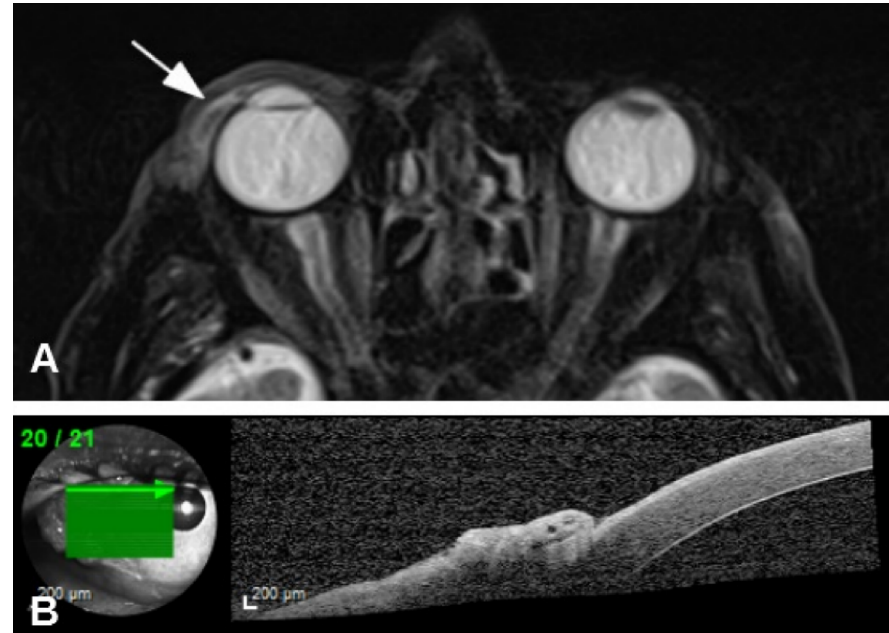
Figure 6: A) Magnetic Resonance Imaging showed lateral rectus muscle involvement. B) Anterior Segment – Optical Coherence Tomography (AS-OCT): a hyperreflective lesion involving conjunctival tissue and spread over corneal surface